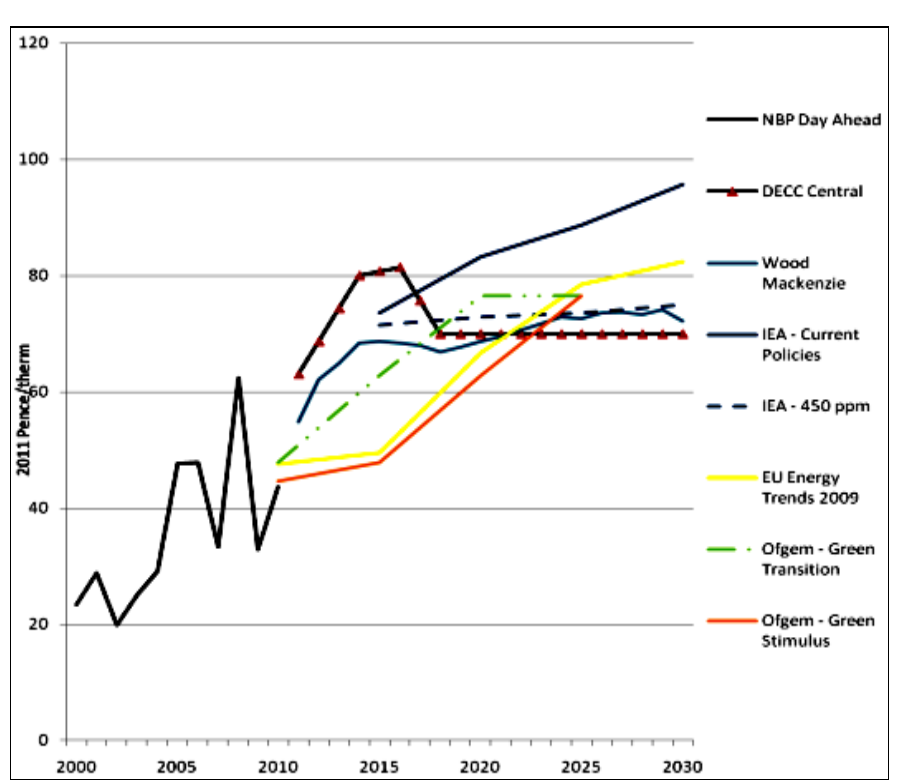
Figure 4. DECC gas price projections, October 2011